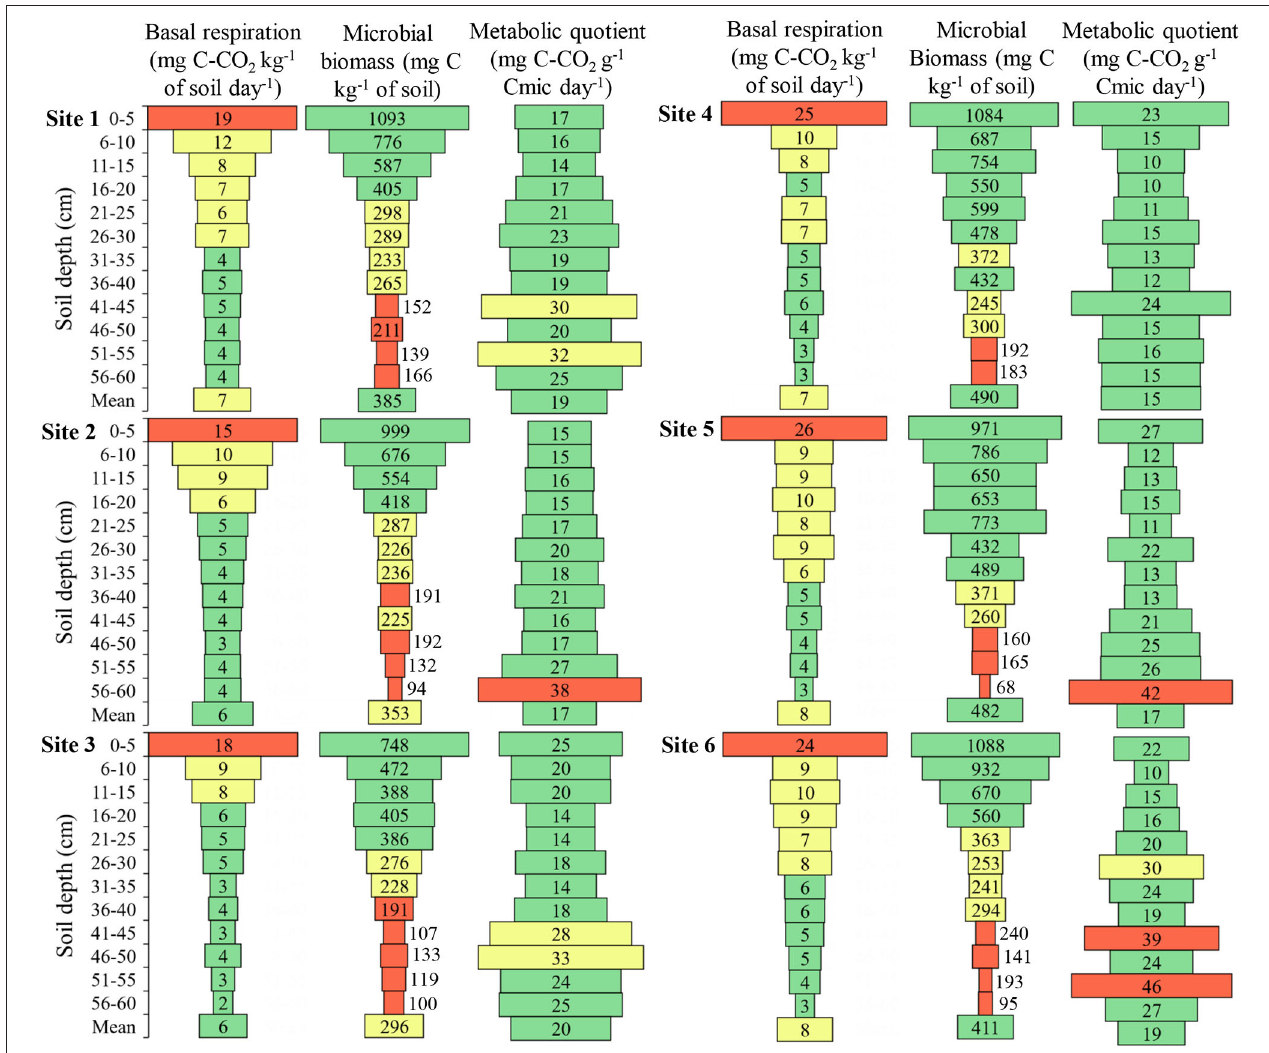
FIGURE 7 | Basal respiration, microbial biomass, and metabolic quotient of the soil in the six sites and at different soil depths. Cmic, Microbial biomass carbon. Green color: adequate values (Respiration ≤ 6.0; Biomass > 375; Quotient ≤ 28.0); Yellow color: intermediate values (Respiration 6.1 – 13.0; Biomass 215.1 – 75.0; Quotient 28.1 – 35.0); Red color: inadequate values (Respiration > 13.0; Biomass ≤ 215.0; Quotient > 35.0). Adapted from Lopes et al.